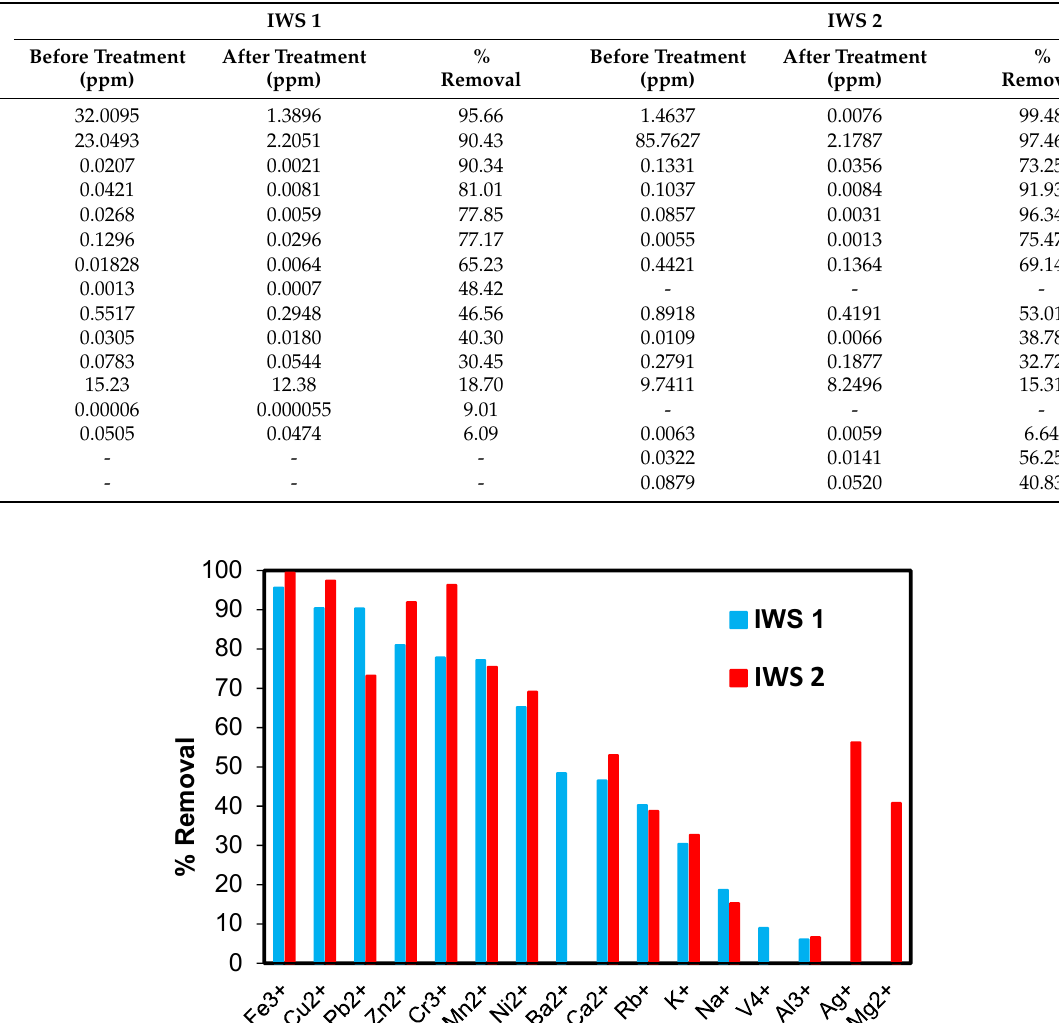
Figure 16. Removal of metal ions in industrial wastewater samples by poly(hydroxamic acid) lig- and.